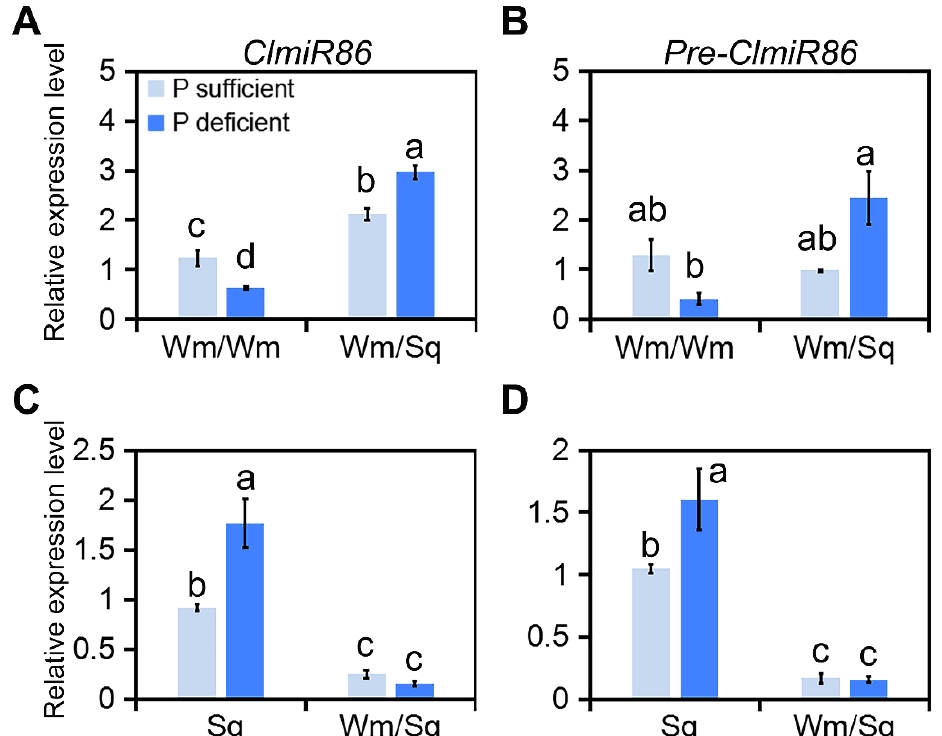
Figure 1. Grafting induced expression of ClmiR86 and Pre-ClmiR86 in watermelon leaves. Expression of ( A ) ClmiR86 and ( B ) Pre-ClmiR86 in the leaves of auto- and squash-grafted watermelon with or without P deficient treatment for 6 h. “Wm/Wm” and “Wm/Sq” represent auto-, and squash-grafted watermelon (Zaojia), respectively. Expression of ( C ) ClmiR86 and ( D ) Pre-ClmiR86 in the roots of non- grafted and grafted squash roots. “Sq” and “Wm/Sq” represent non-grafted and grafted squash roots, respectively. Different lower-case letters denote a significant difference in relative expression level ( p < 0.05, one- way ANOVA and then Tukey’s test for multiple comparisons). Values are means ± SD ( n = 3).